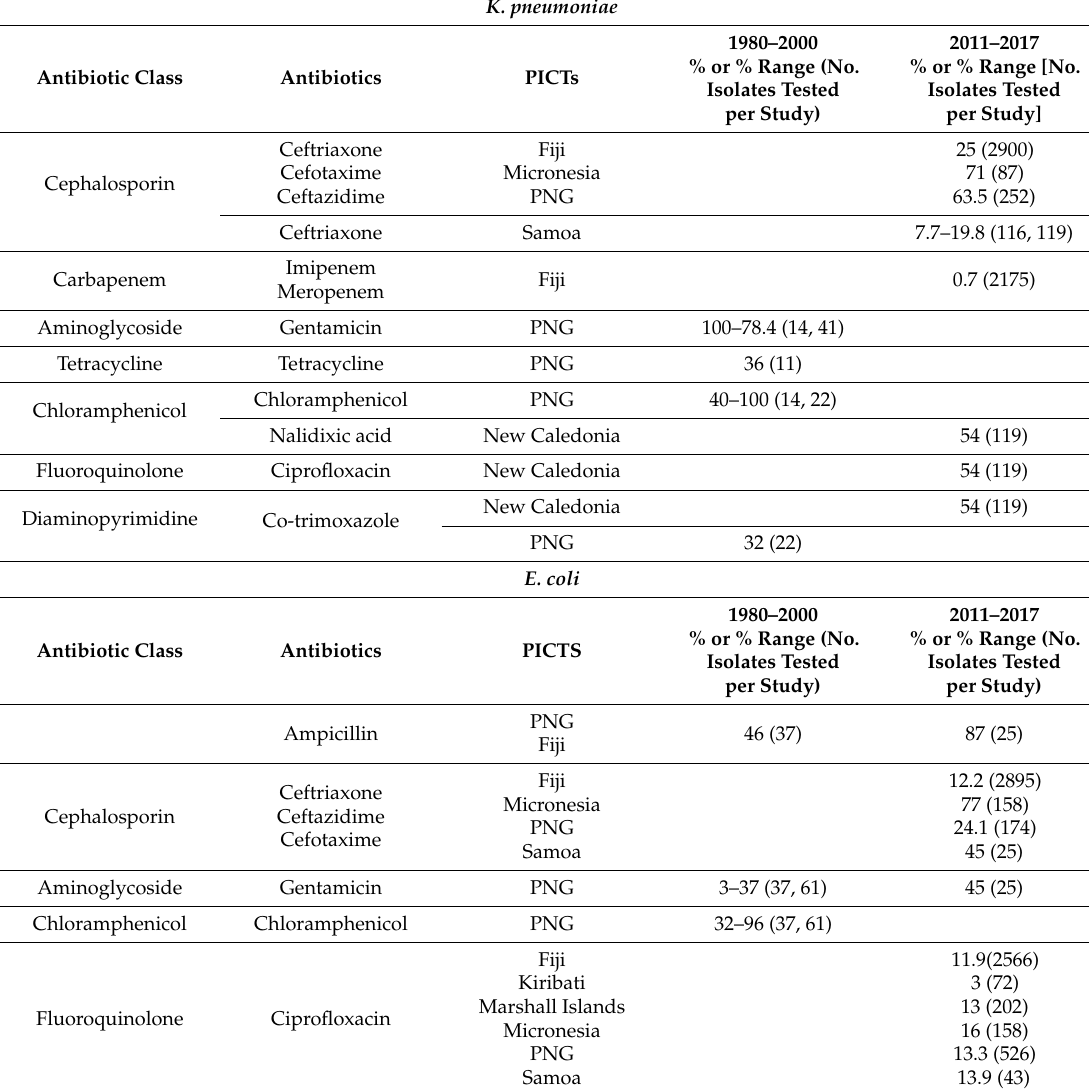
Table 1. Prevalence of ABR in Klebsiella pneumoniae and Escherichia coli in PICTs reported by country and